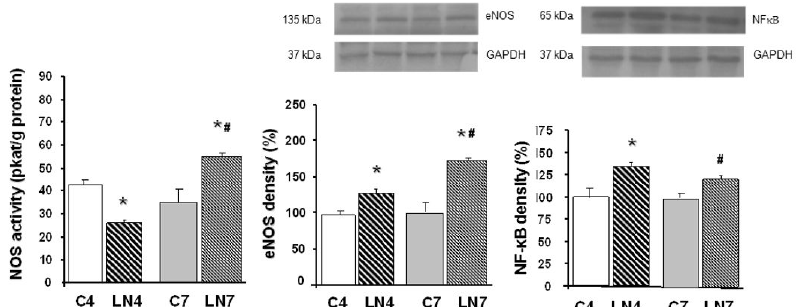
Figure 4. E ff ect of 4- and 7-week N G -nitro-L-arginine methyl ester (L-NAME) treatment on NO synthase (NOS) activity, endothelial NOS (eNOS) protein expression, and nuclear factor-kappaB (NF- κ B, p65) protein expression in the kidney. Group treated with L-NAME for 4 weeks (LN4) and age-matched controls (C4), group treated with L-NAME for 7 weeks (LN7) and age-matched controls (C7). * p < 0.05 compared to age-matched controls, # p < 0.05 compared to